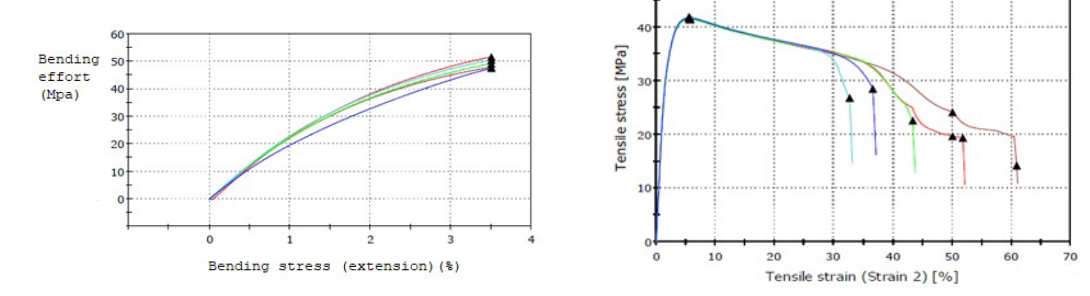
Figure 4. 3-point bending test for PP 15wt% fiber composite.